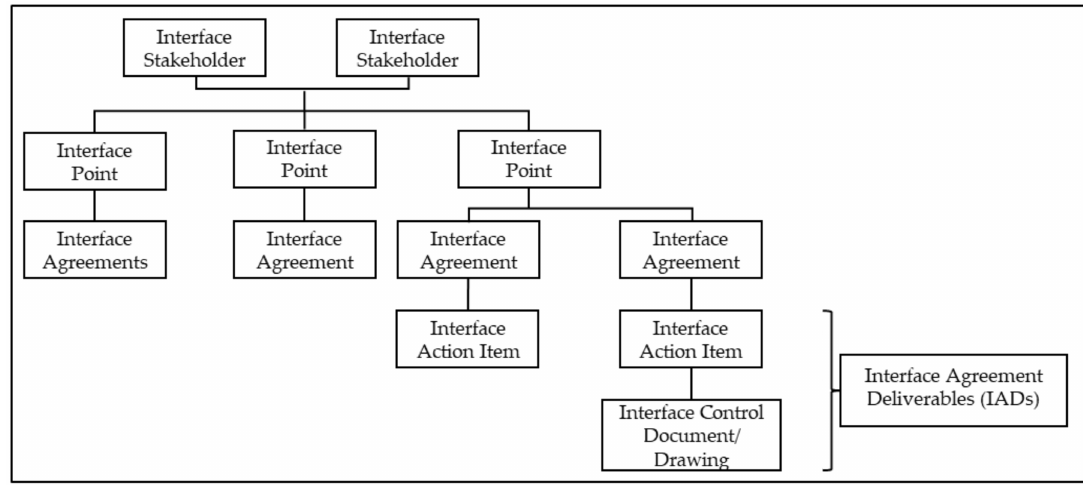
Figure 1. A simplified interface management system